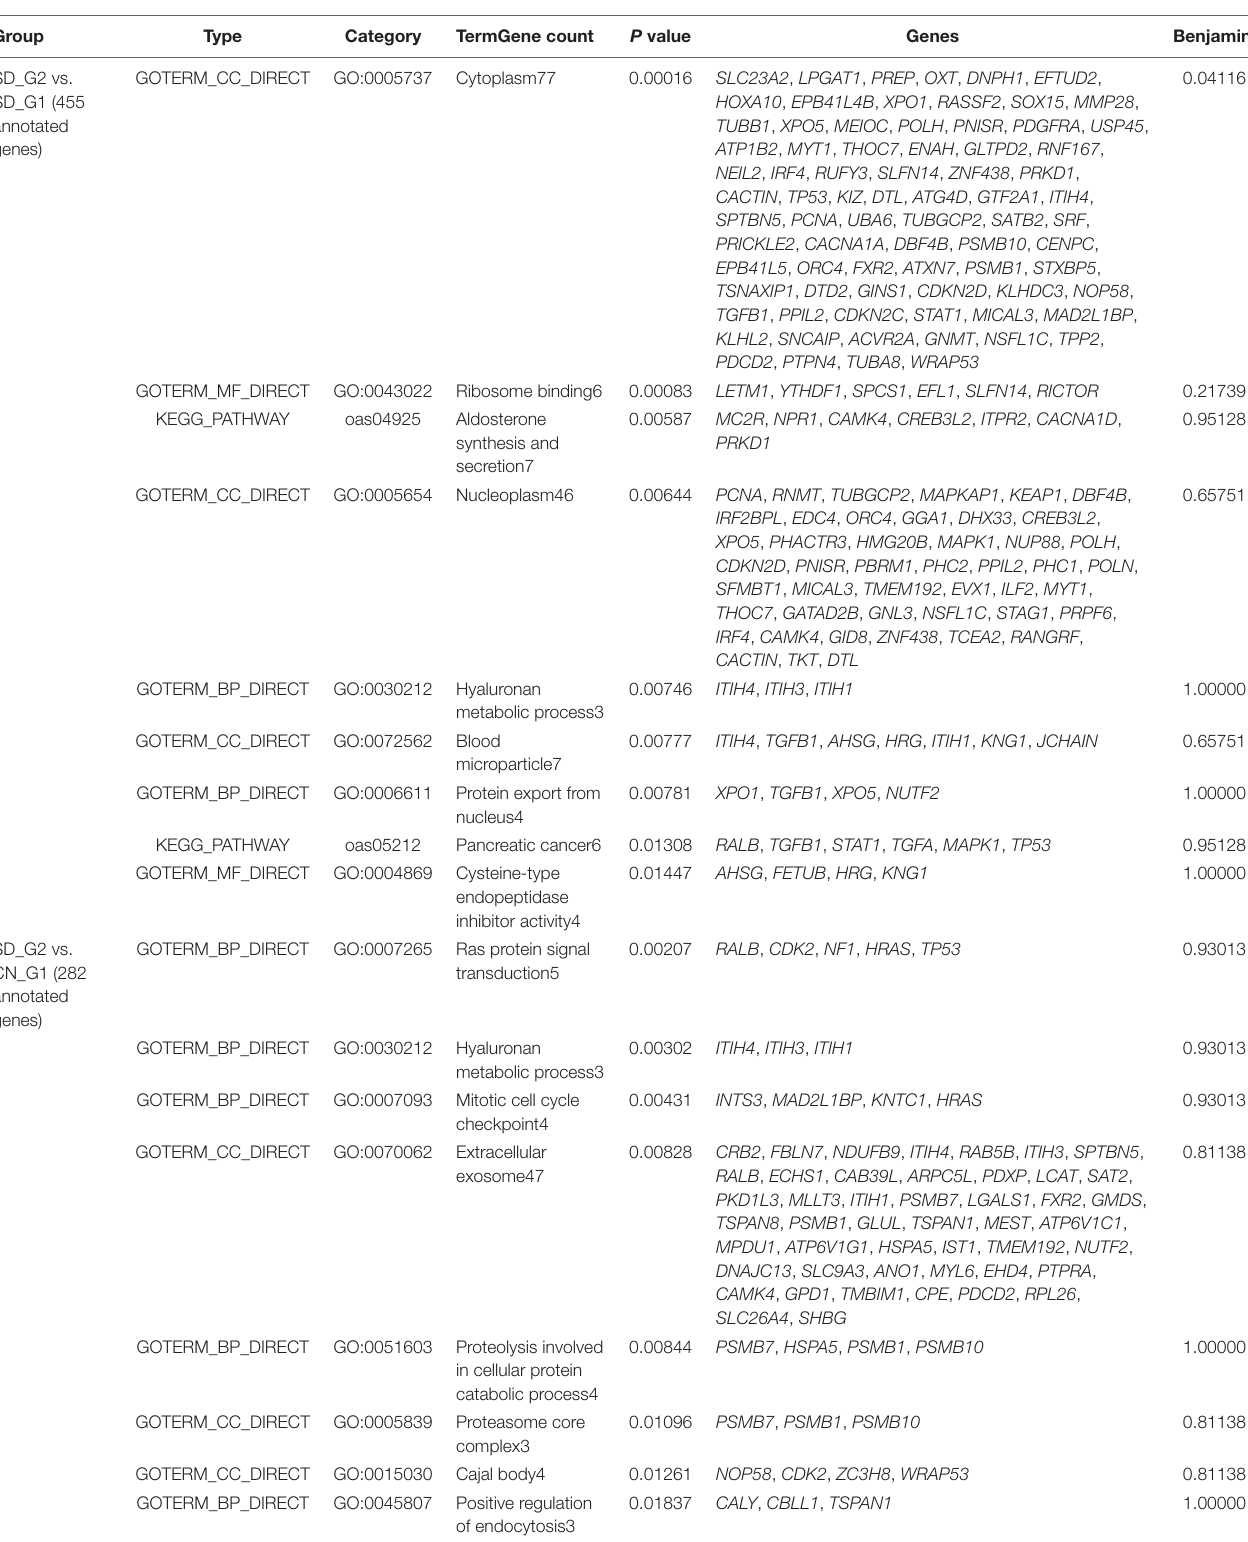
TABLE 5 | Enriched functional terms and their enrichment scores following DAVID analysis for genes identified by all methodologies in the SD_G2 (BU, HA, KA, and SH) Sudanese sheep group.